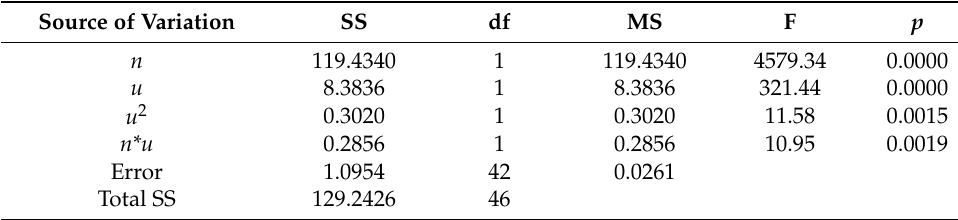
Table 2. Model of polymer mass flow rate G —ANOVA table, R 2 = 0.99; R adj2 = 0.99. Source of